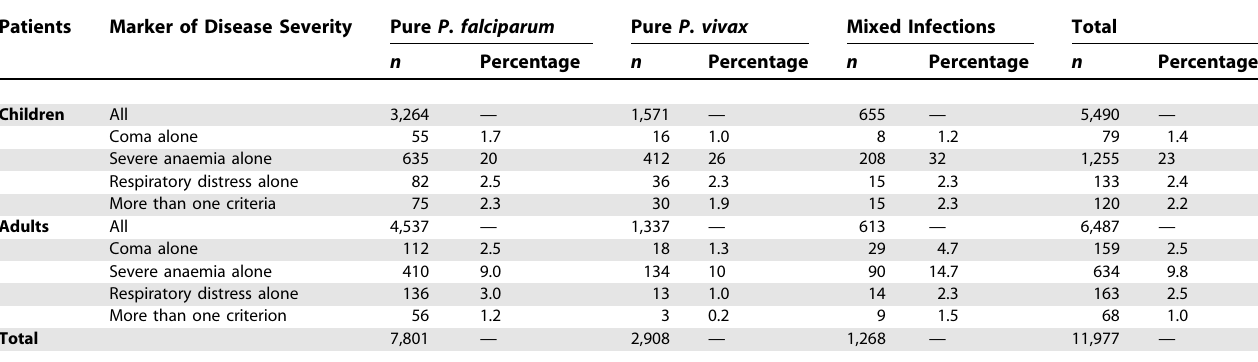
Table 2. Prevalence of Severe Malaria Stratified by Species of Infection for Patients Admitted with Clinical Malaria to RSMM Hospital (2004–2007) Patients Marker of Disease Severity